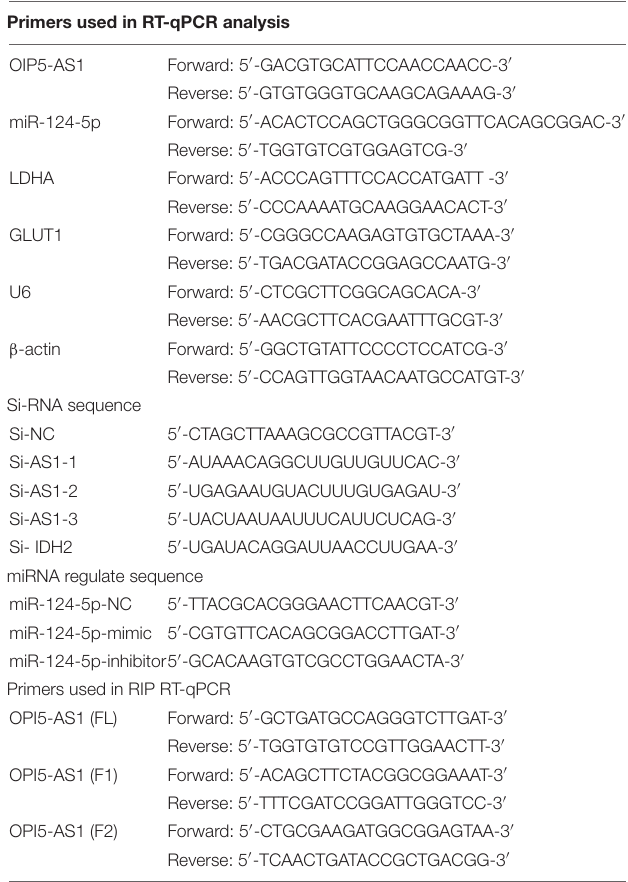
TABLE 1 | Sequences of primers of qPCR, si-RNA, and miRNA. Primers used in RT-qPCR